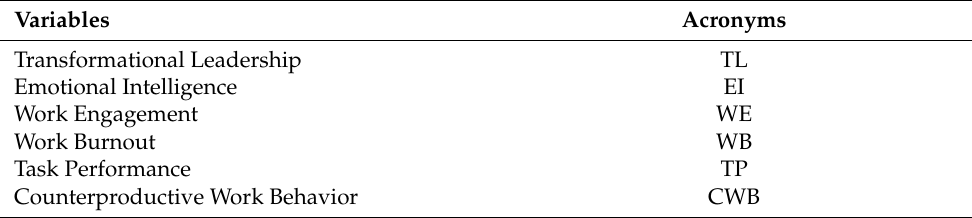
Table 1. The acronyms of